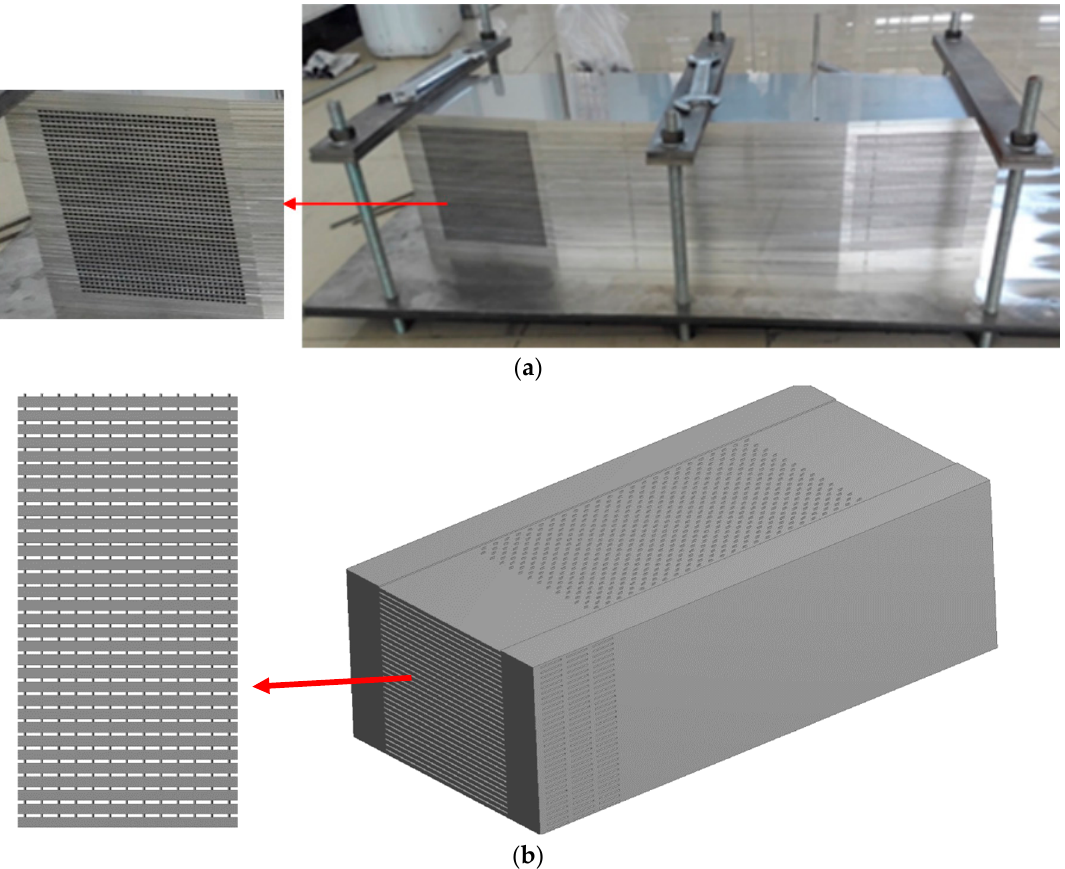
Figure 2. Entrance inlets of two types of PCHEs, ( a ) entrance inlets of continuous fin PCHE, and ( b ) entrance inlets of discontinuous fin PCHE.